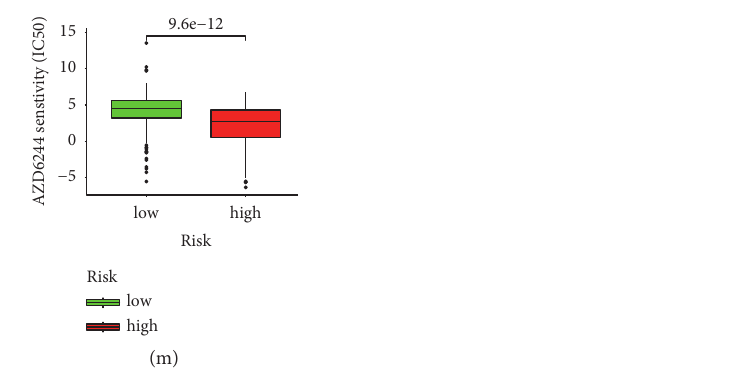
Supplementary data 1: 2843 immune genes were down- loaded from the ImmPort database. Supplementary data 2: a matrices. Supplementary data 3: 694 immune-related